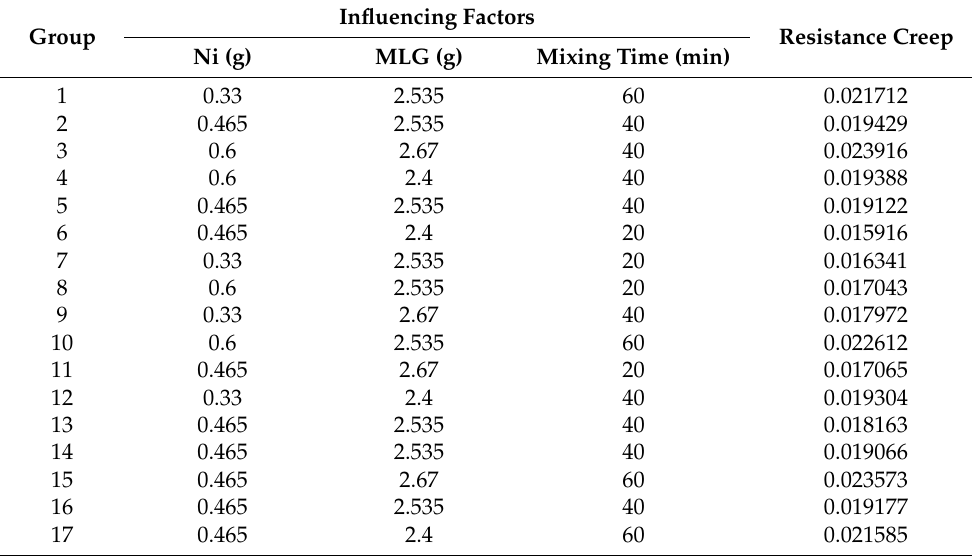
Table 2. Orthogonal experimental design and results.